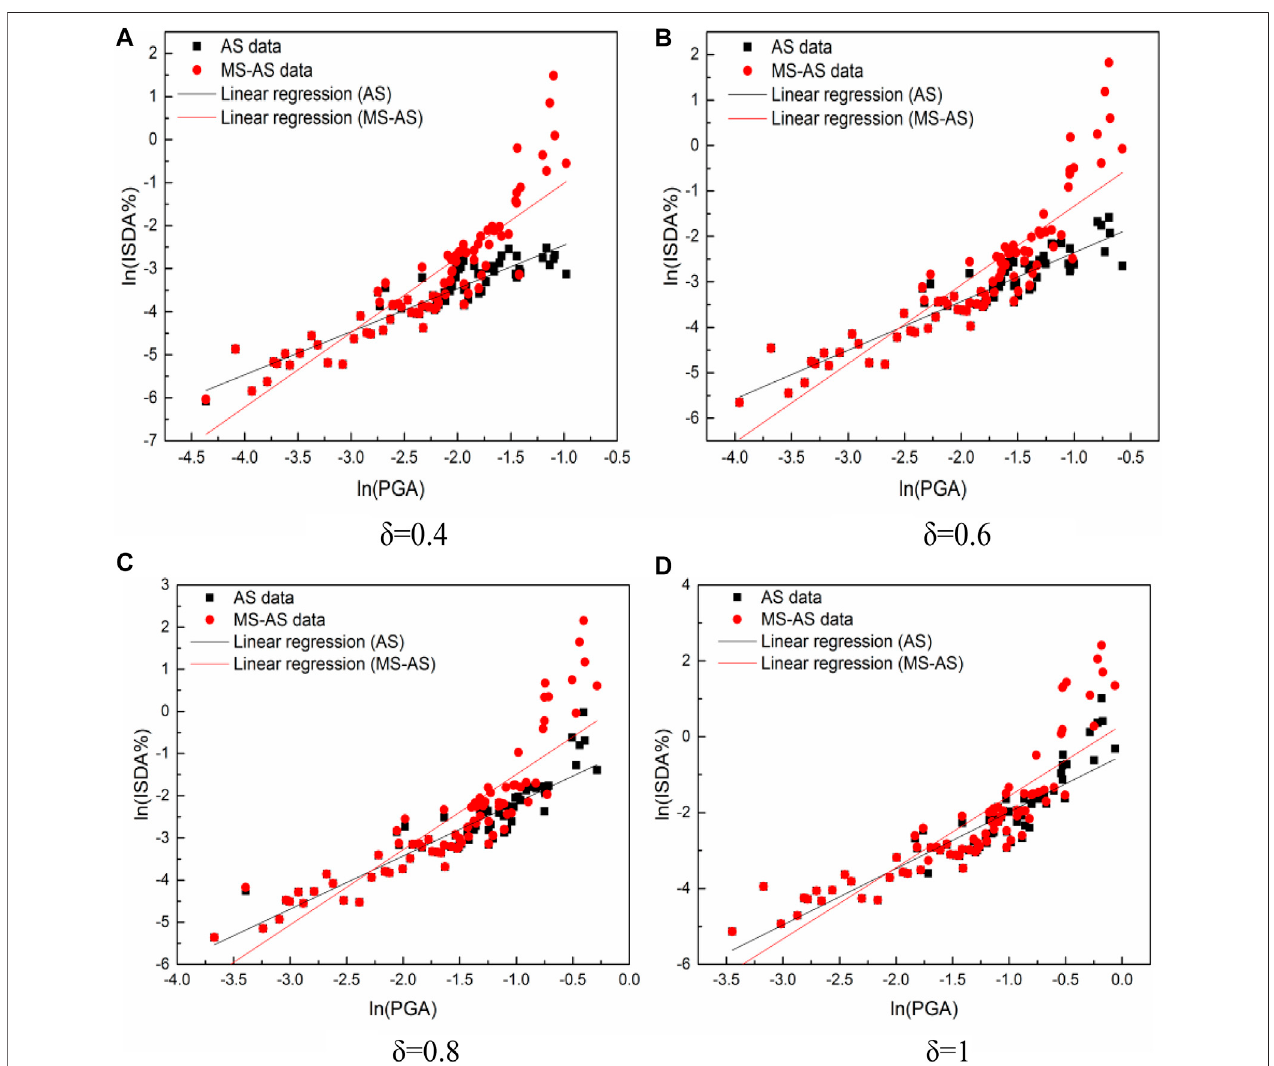
FIGURE 8 | Probabilistic seismic demand model of URM subjected to aftershock. (A) δ (cid:2) 0.4 (B) δ (cid:2) 0.6 (C) δ (cid:2) 0.8 (D) δ (cid:2) 1.